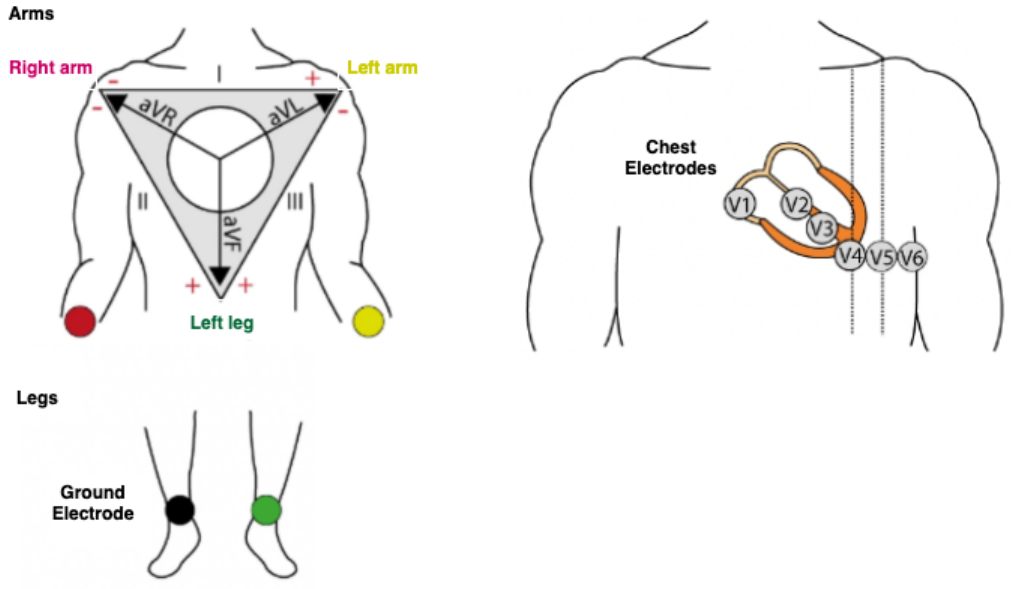
Figure 1. The placement of ECG electrodes on the chest, arms, and legs